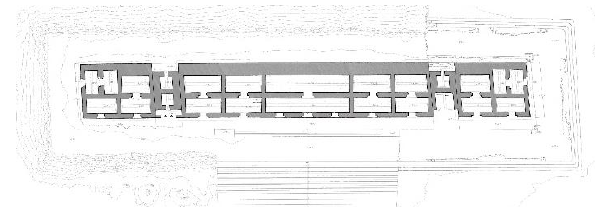
Figure 9. Floor plan of de Palace of the Governor. (Project MAYATECH 2019).